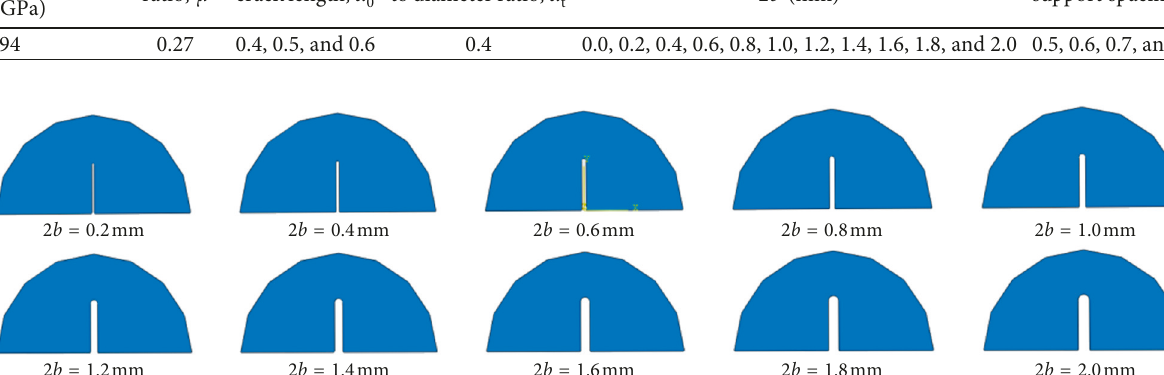
Figure 3: NSCB models with different widths of the prefabricated cracks.